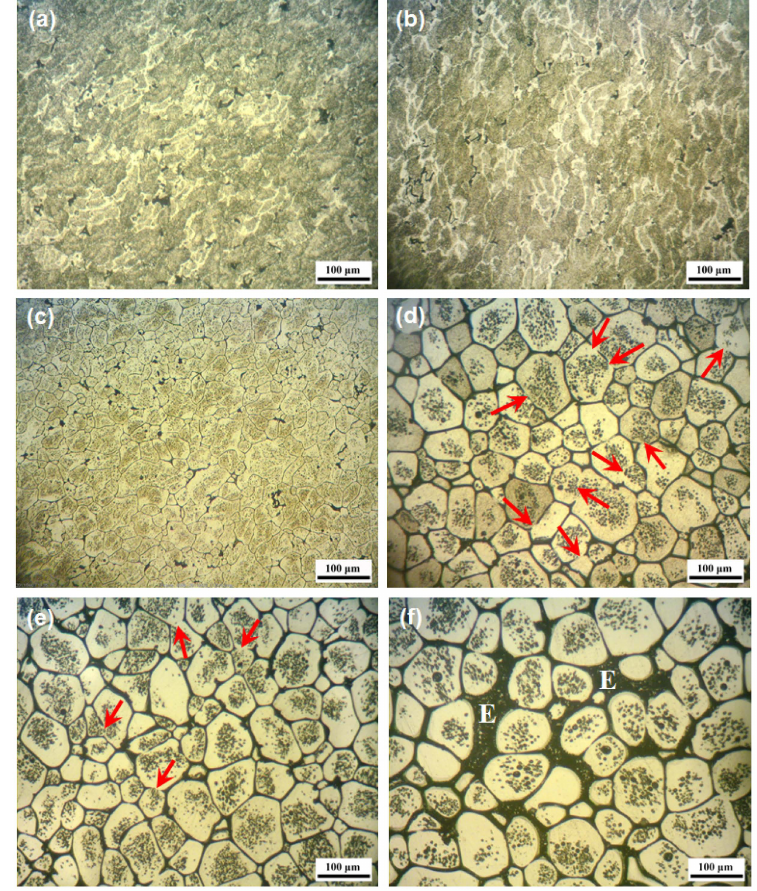
Figure 3. Optical micrographs of samples compressed 20% and isothermally heat treated at 600 ˝ C for ( a ) 0 min; ( b ) 5 min; ( c ) 10 min; ( d ) 15 min; ( e ) 25 min; ( f ) 35